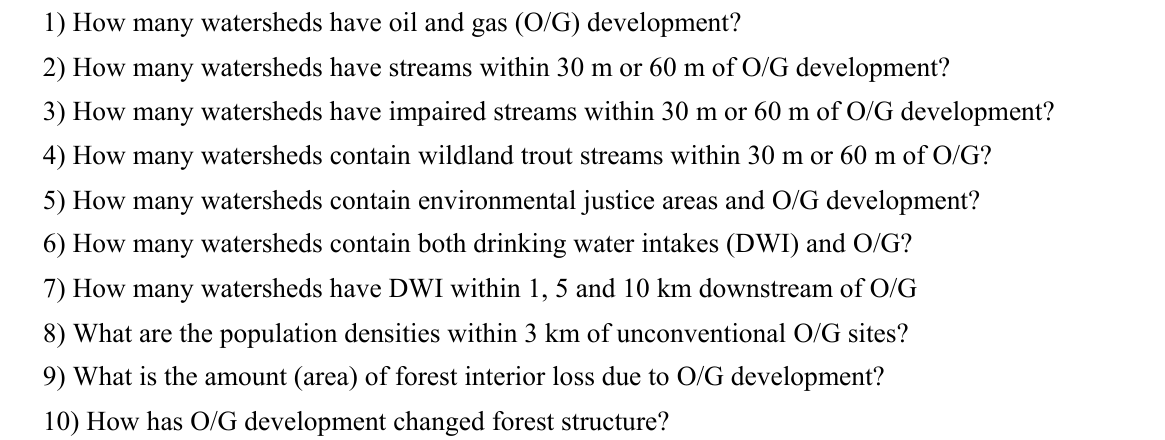
Table 1. Assessment